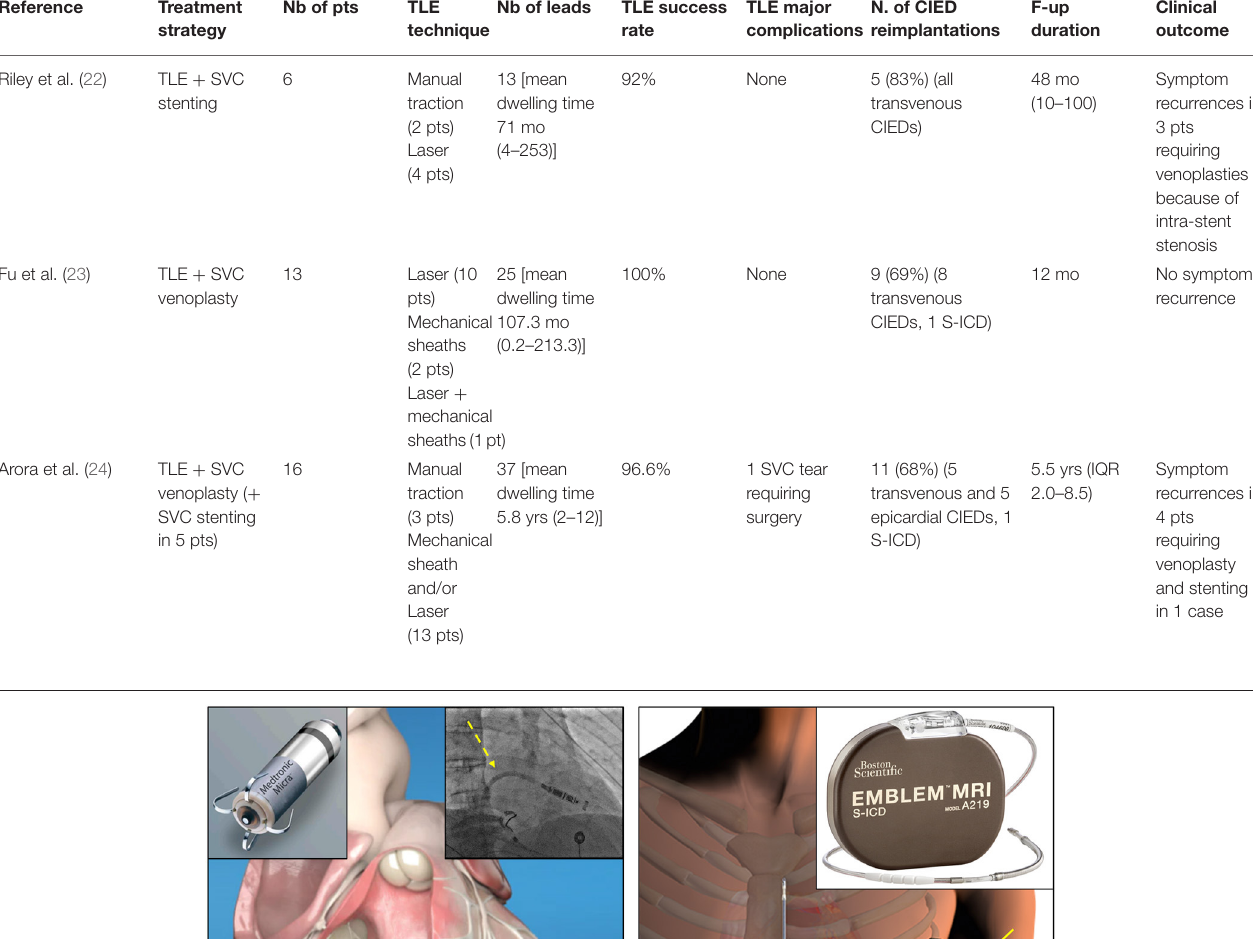
TABLE 1 | Data from the largest series available in literature on TLEs as a part of percutaneous management of SVC syndrome. Reference